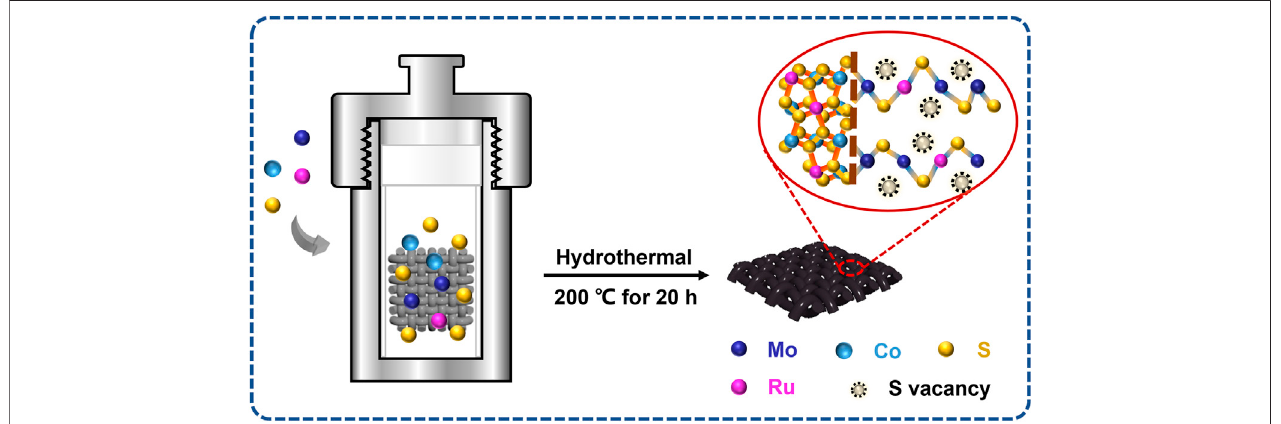
FIGURE 1 | Schematic representation of the fabrication of Ru-MoS 2 -CoS 2 /CC samples.